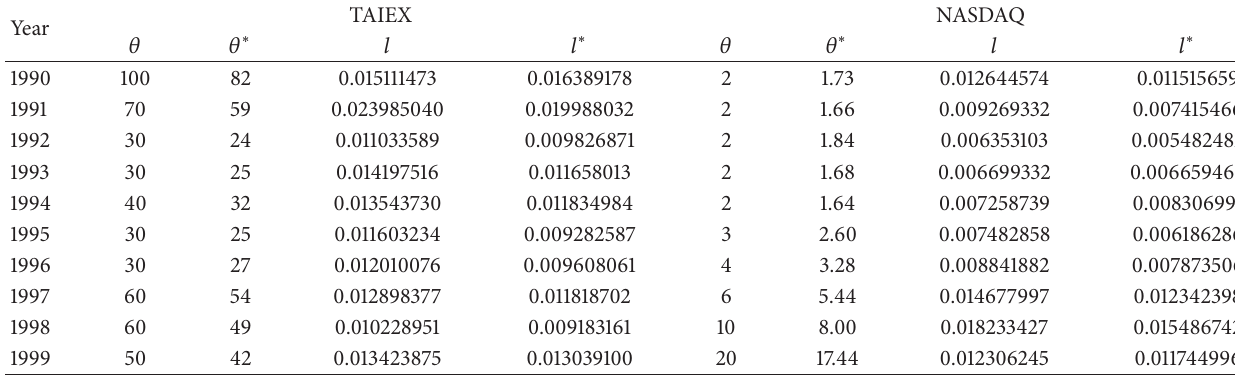
Table 2: Different length of intervals for TAIEX and NASDAQ problems.